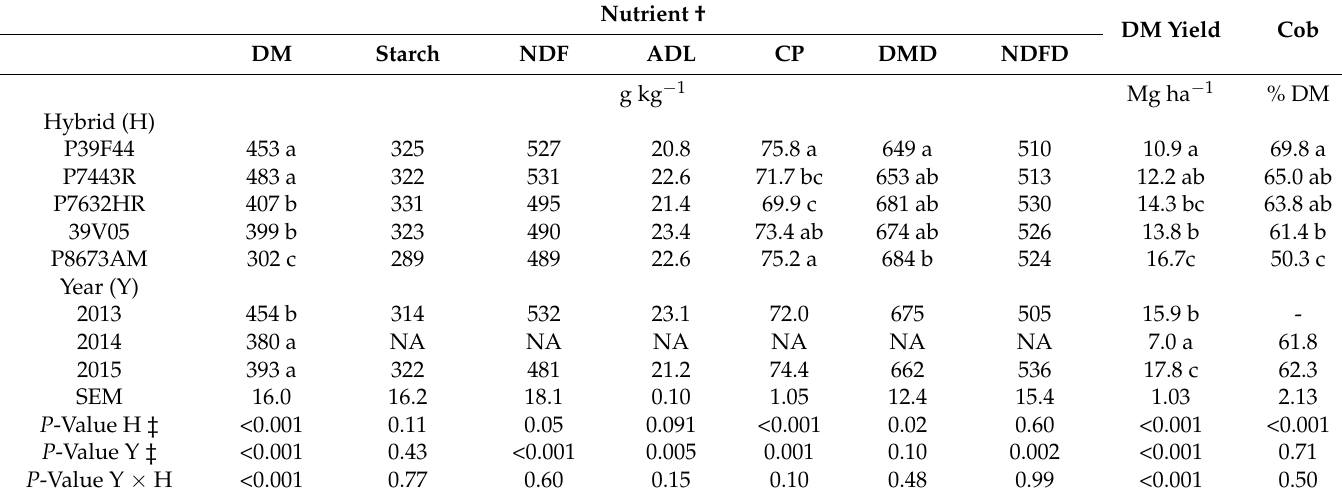
Table 6. Concentration of DM, starch, NDF, ADL, CP, DMD, NDFD, DM yield, and cob percentage for whole-plant corn grown at Lethbridge (Alberta) over three